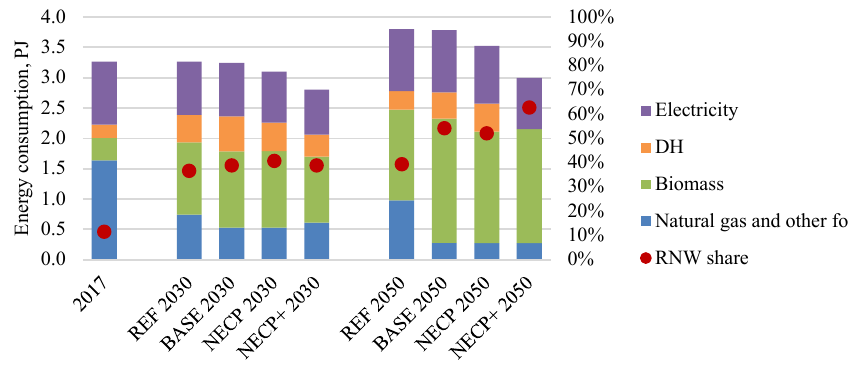
Fig. 9. Energy consumption in food sub-sector in the modelled scenarios.